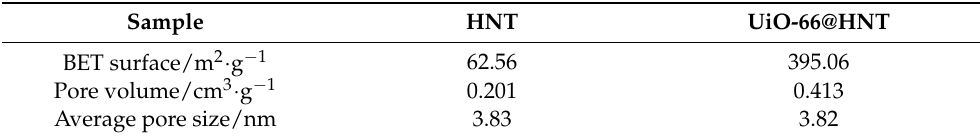
Table 1. BET data of HNT and UiO-66@HNT.